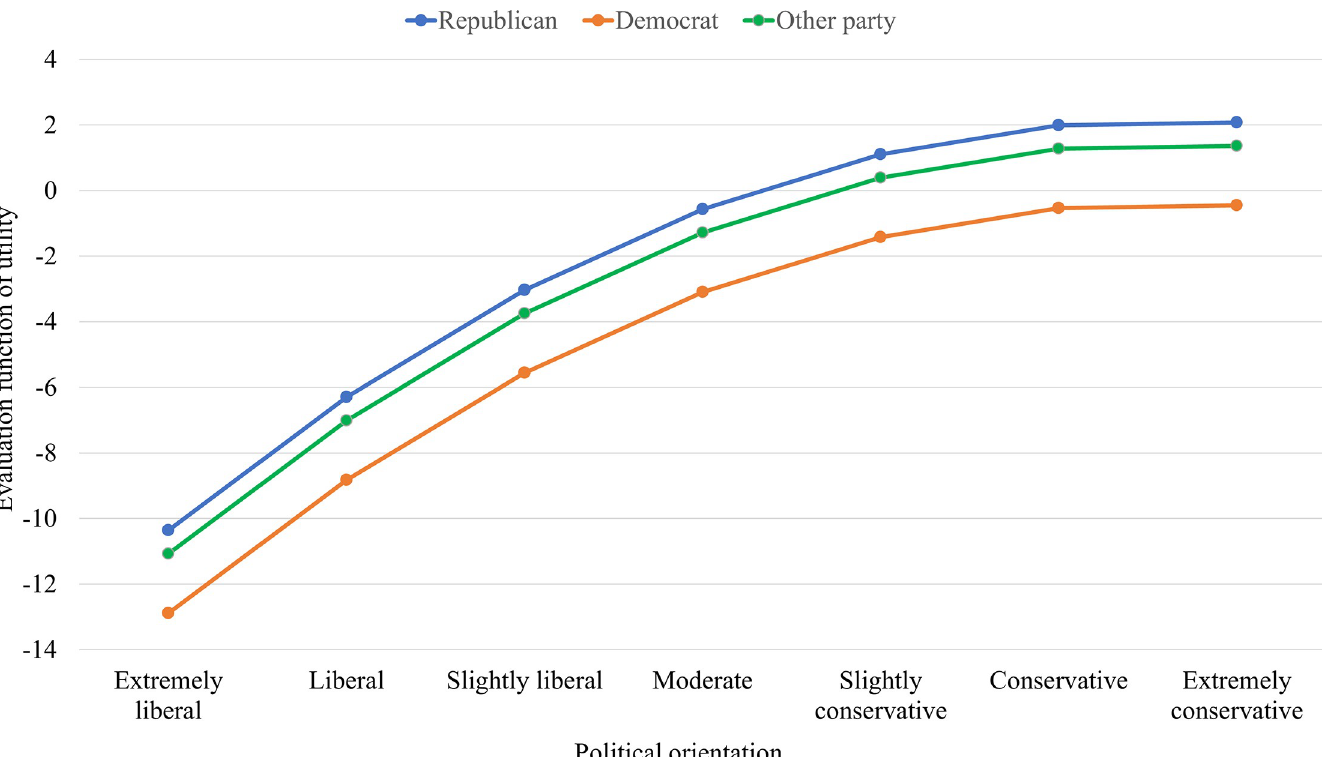
Fig 1. Evaluation function of utility from linear shape, quadratic shape, and partisanship effects to political orientation among NetSense study participants.